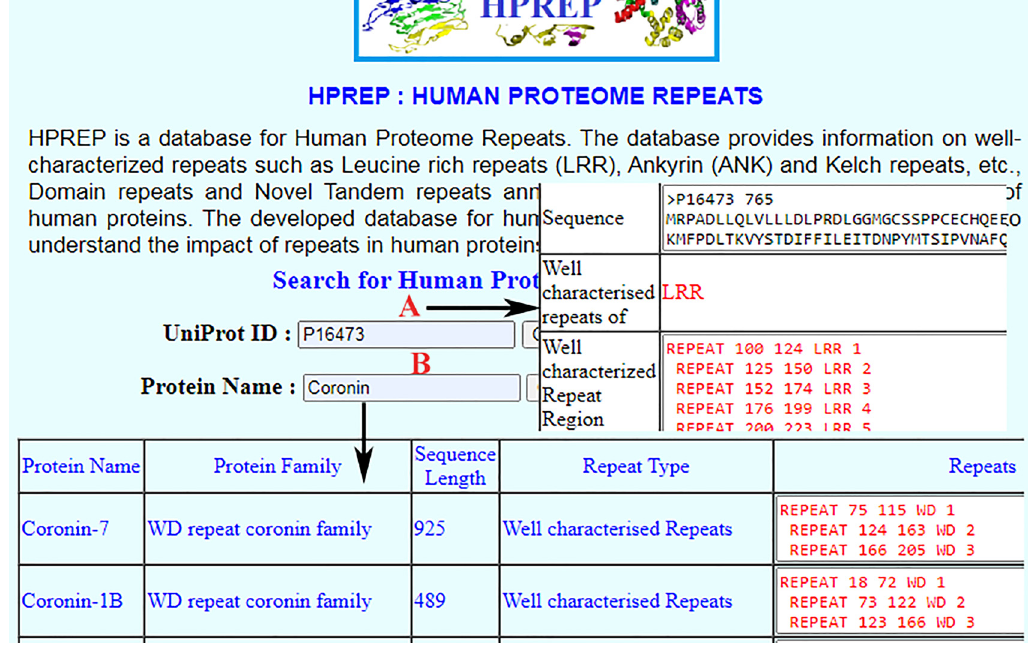
Figure2: ThehomepageofHPREPdatabaseisshownwith(A)therepeatsofThyrotropinreceptorproteinthatwasobtainedbythe searchusingUniProtID(P16473)oftheproteinand(B)thelist of sevenCoroninnamecontainingproteinswith repeatdetailsthat was obtained by a search using protein name